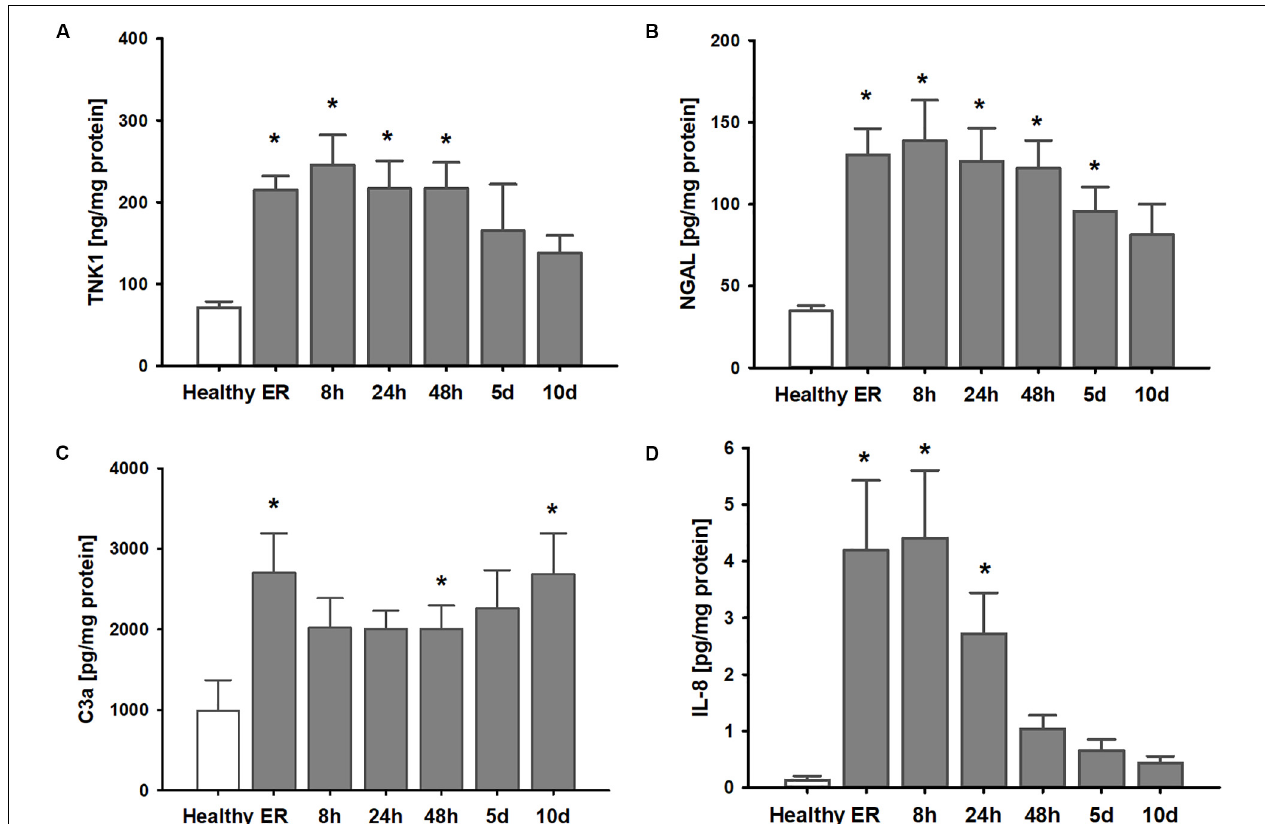
FIGURE 5 | Elevation of systemic TNK1 and plasma markers of organ damage and inflammation in severely injured patients. In polytraumatized (PT) patients, plasma concentrations of (A) non-receptor tyrosine-protein kinase 1 (TNK1) and (B) of the kidney injury marker neutrophil gelatinase-associated lipocalin (NGAL) were significantly increased starting upon arrival at the emergency room (ER) and remained elevated throughout the first days after injury compared to healthy volunteers (healthy). Plasma concentrations of the activated central complement component C3 (C3a) were increased in trauma patients throughout the entire observation period (C) . Systemic interleukin 8 (IL-8) was significantly increased especially during the first 24 h after trauma (D) . * p < 0.05 vs. healthy, n = 7-8 healthy, and n = 11-13 PT patients.